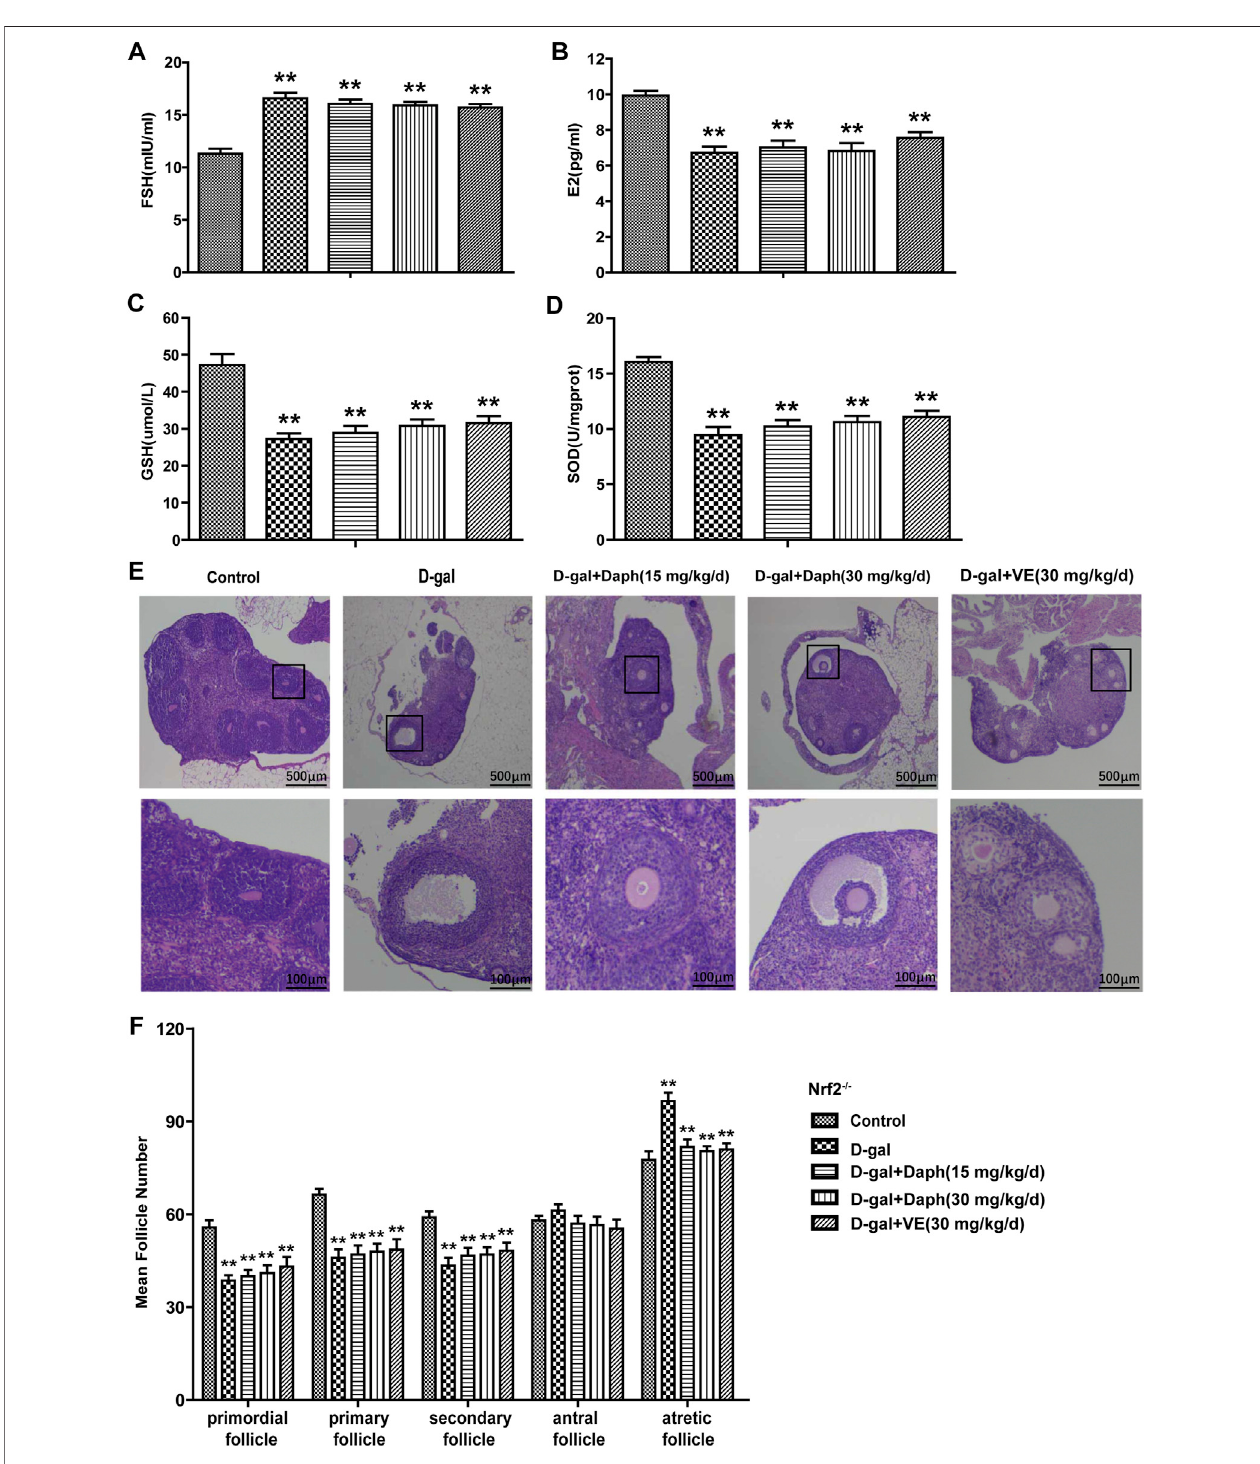
FIGURE 6 | Knockout of Nrf2 abolished the protective capability of Daph for ovarian function and follicular development. (A,B) The serum FSH and E2 levels were tested in the fi ve groups in Nrf2 − / − mice. (C,D) GSH and SOD expression in ovarian tissues was tested. (E) Follicles were observed after H&E staining. (F) Summarizing the numbers of follicles at different developmental stages. All data are shown as means ± SEMs, n = 5. Statistical signi fi cance: ** p < 0.01.